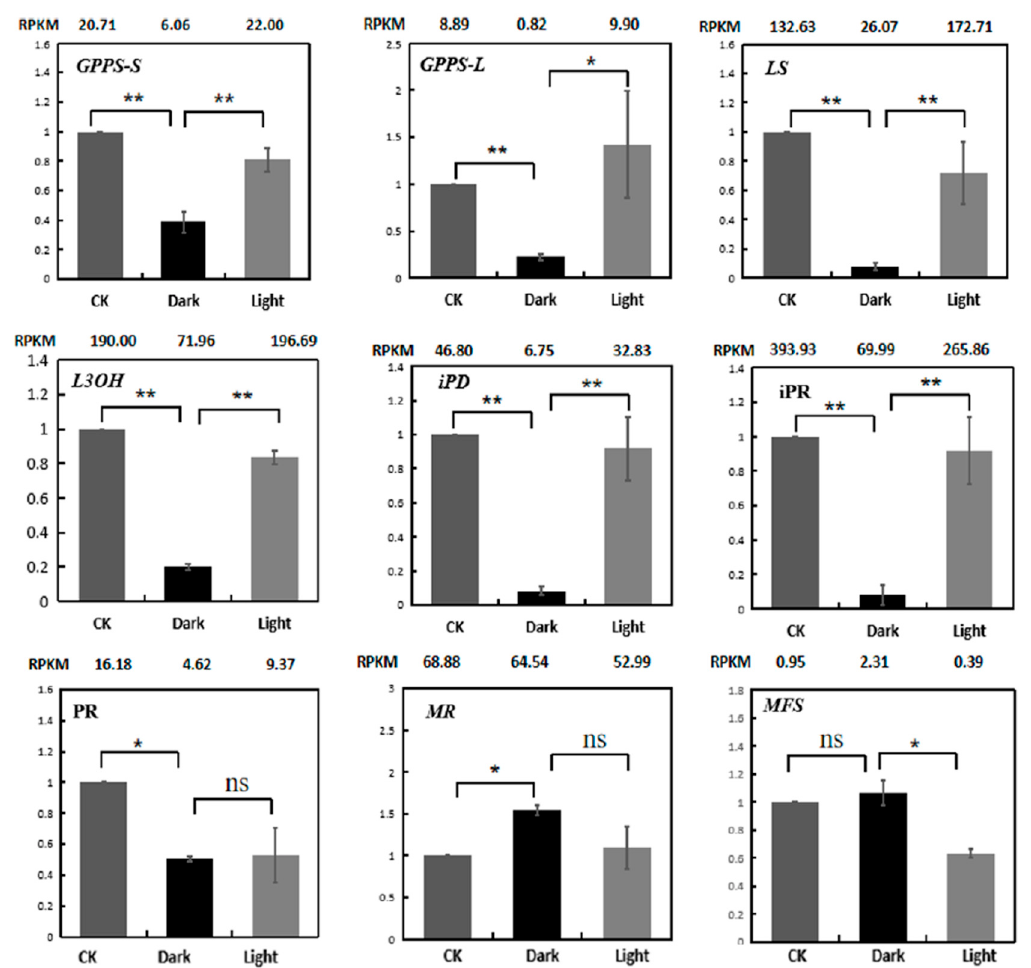
Figure 8. Expression validations of nine menthol synthesis genes in the control, darkness and recovery light samples using qRT-PCR. The RPKM values obtained from RNA-Seq data are shown at the top of each figure. The level of significance, obtained with Student’s t -test, is denoted as follows: * p < 0.05; ** p < 0.01. ns, not significant. Each value is the mean of at least three